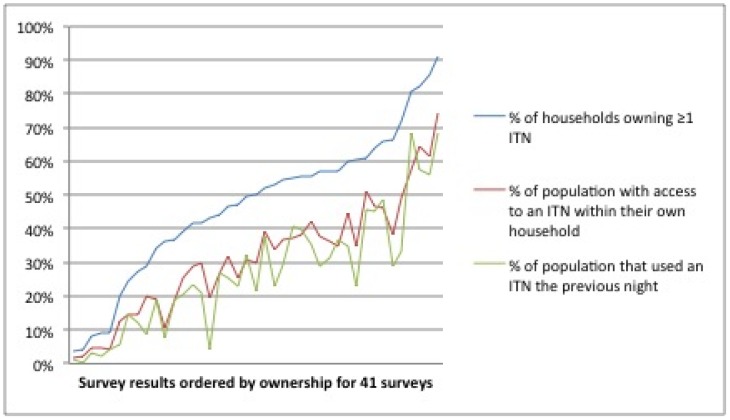
Ownership, access and use of ITNs for all datasets.Survey results are ordered by ownership. Previously, the visual gap between ownership (blue line) and use (green line) made it seem as though the use gap was vast. When use is compared to access (red line), however, a much closer relationship – and narrower gap – is immediately apparent.